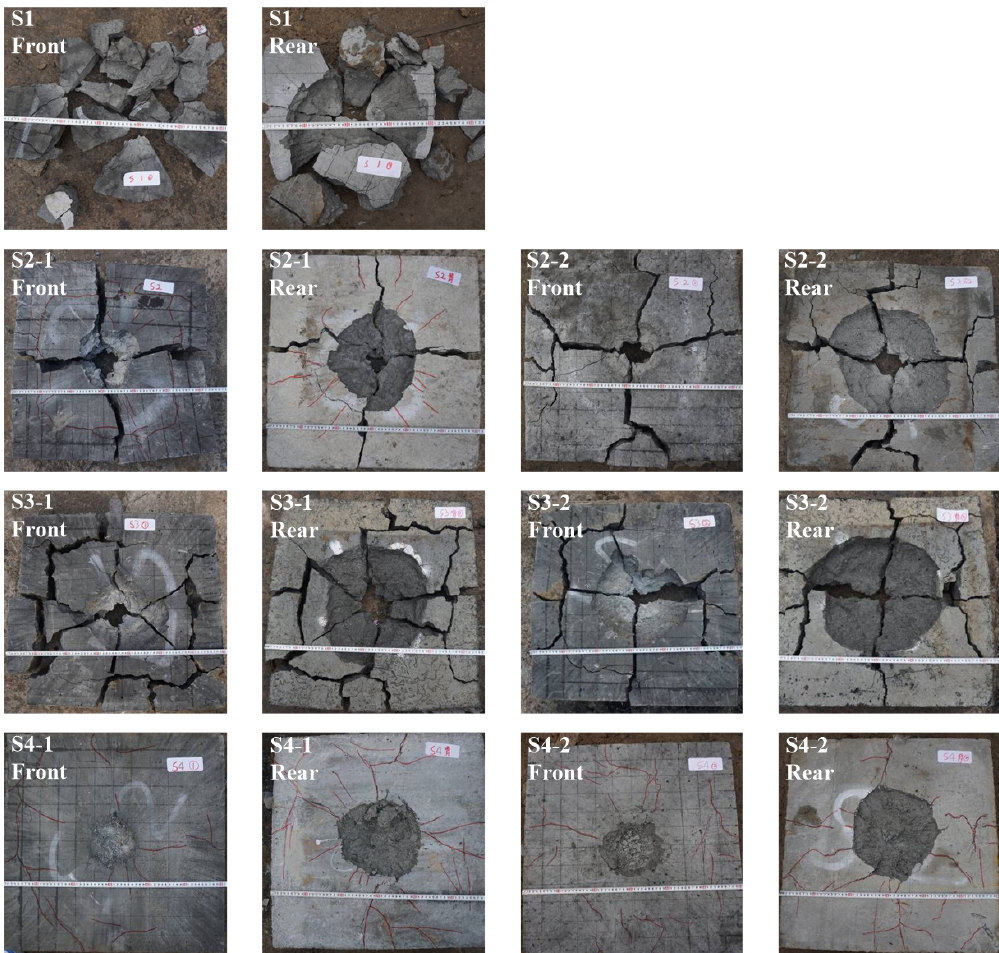
Figure 6. Damage mode of concrete panels without/with fiber